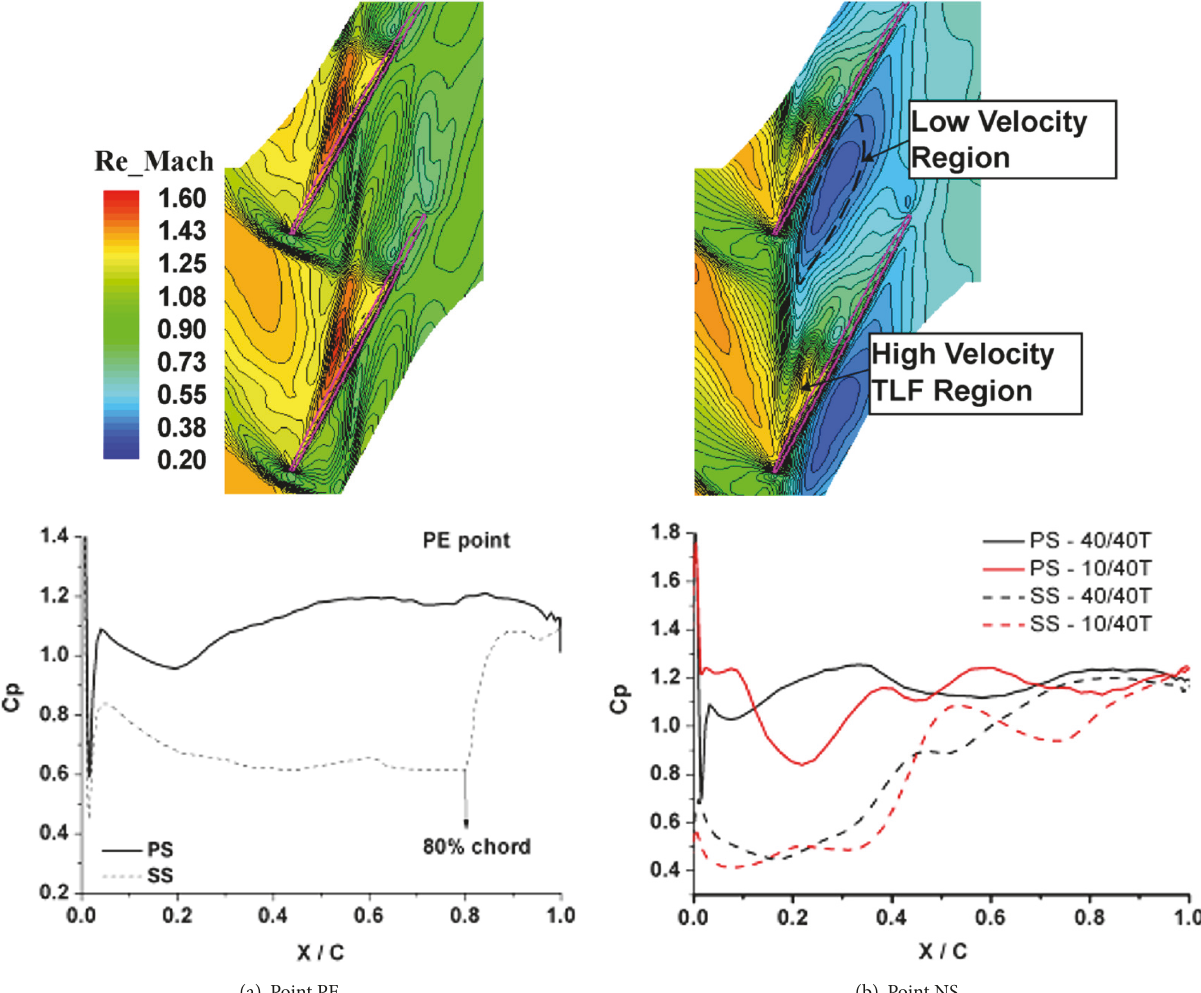
Figure 2: The top two pictures show the relative Mach number contours at 99% span, a plane at the middle of the tip clearance, at points PE and NS. The bottom two pictures depict the blade loadings using the surface pressure coefficient distributions along the blade’s axial chord. ([12]). Figure reproduced from LIN et al.